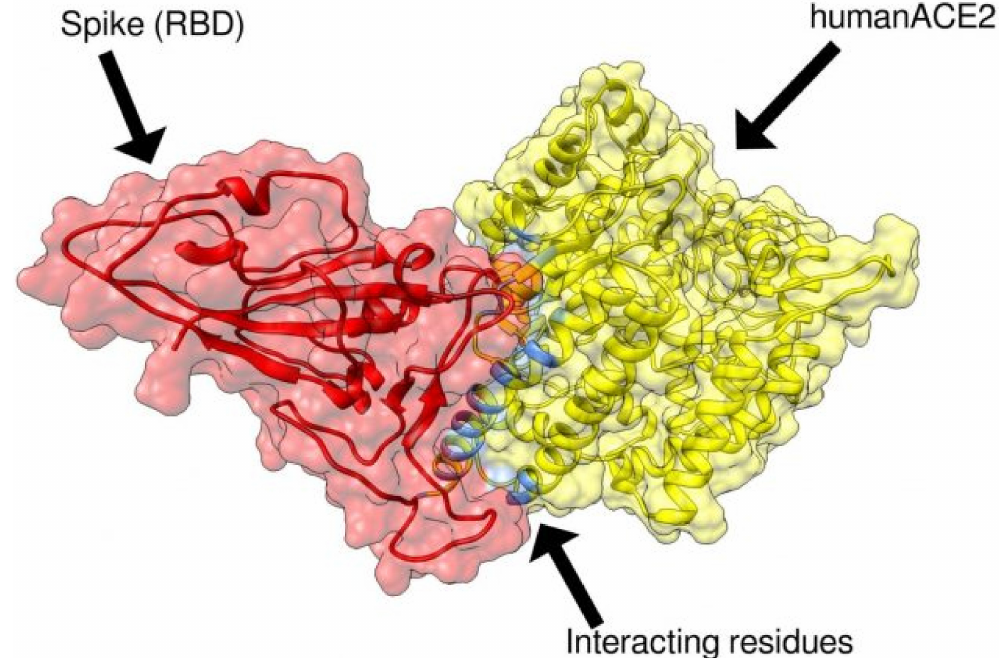
Figure 1. The COVID-19 spike protein shown in red binds to the human ACE2 receptor shown in yellow at known amino acid residues prior to gaining entry into epithelial cells lining the lung. Vaccines are designed to increase human antibodies capable of binding to the COVID-19 spike protein thereby blocking the virus from binding to ACE2 receptor and preventing infection [credit: Flinders